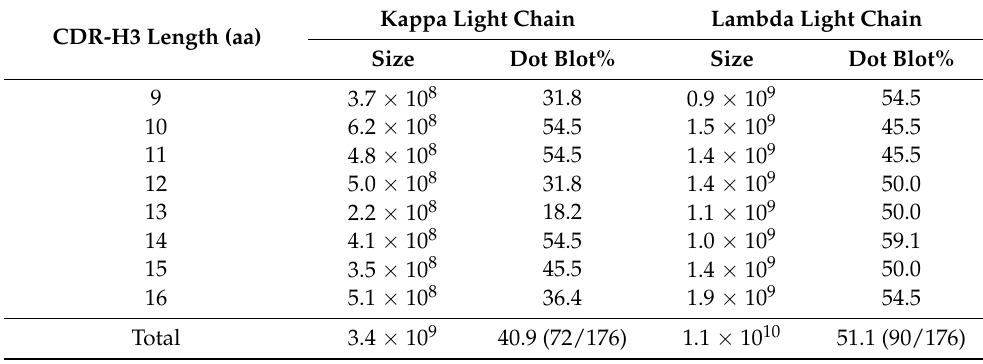
Table 1. Sizes estimated by transformation titers and dot blot-positive percentages of OPAL-T sub-libraries.